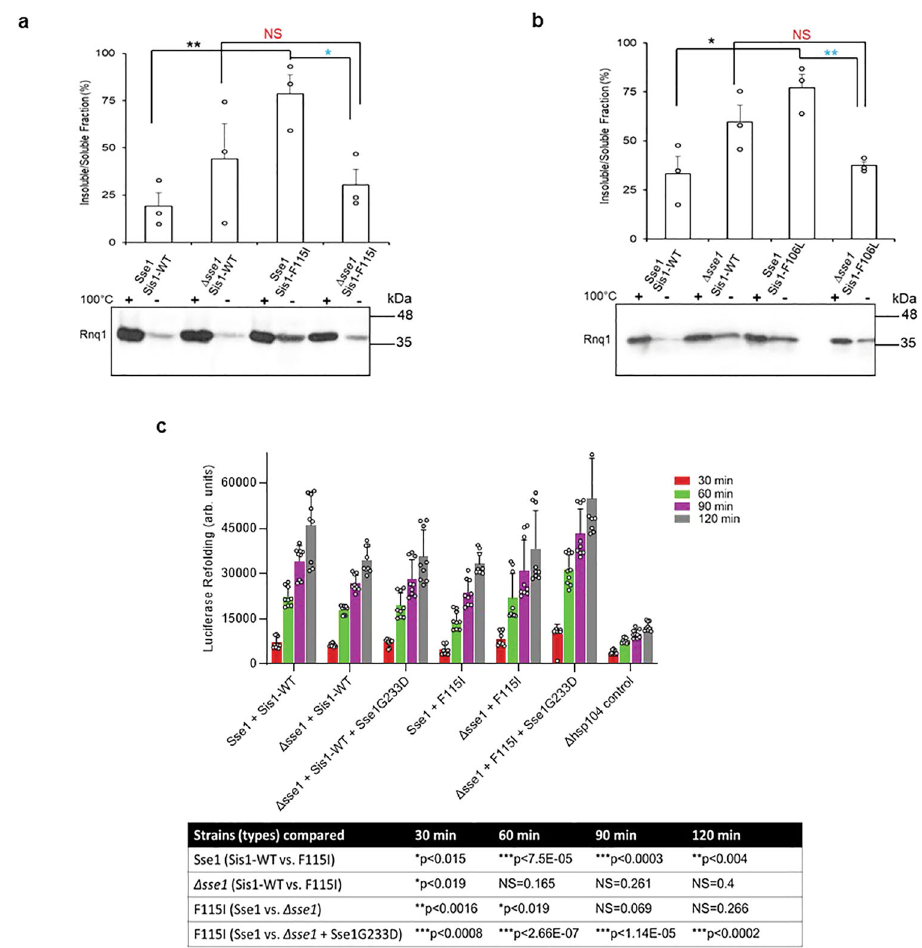
Fig. 7 | Deletion or inhibition of Sse1 function rescues prion propagation of [ RNQ +] and restored impaired FFL refolding. a , b Deletion of Sse1 partially sup- presses prion loss caused by LGMDD1 mutants. Analysis of prion propagation in Sse1 and Δ sse1 strains harboring s.d.medium [ RNQ +],expressing eitherSis1-WT or Sis1-F115I or Sis1-F106L by well-trap assay. Cell lysates were incubated at room temperature ( − ) or 100°C and subjected to SDS-PAGE and western blot using an α Rnq1 antibody.Rnq1thatisnot sequesteredinaggregateswillenterthegelinthe unboiled sample, which indicates destabilization of the [ RNQ +] prion. The western blottingwasdoneintriplicateandrepresentativeimageisshownhere.For a , b ;the lines above the bars shows the samples which were compared and ** p <0.01,